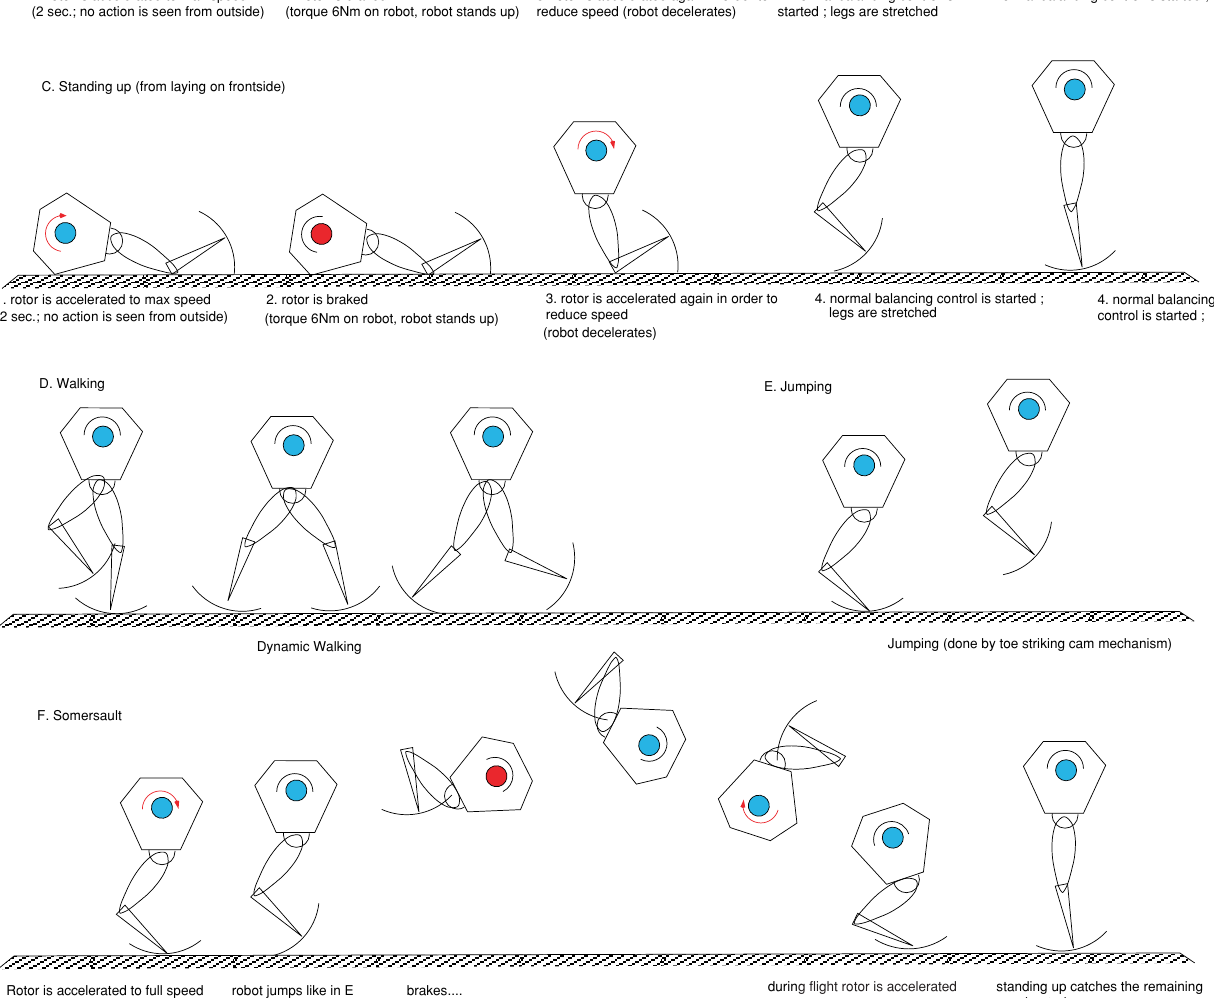
Figure 7 Possible rapid movements suggested for the NEDO artistic biped project. The figure displays possible movements of robot that uses a rotor–brake system. The movements B and F have been actually realised in a prototype robot at the Aichi World